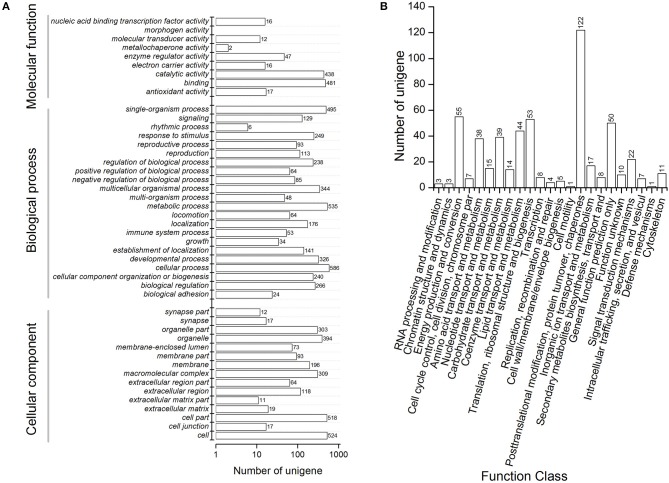
Functional annotation including (A) clusters of orthologous groups (COG) classification and (B) Gene Ontology (GO) terms of differentially expressed proteins in proteomic analysis of Bactrocera minax. Differentially expressed proteins were filtered with >1.2-fold change and Q < 0.05.